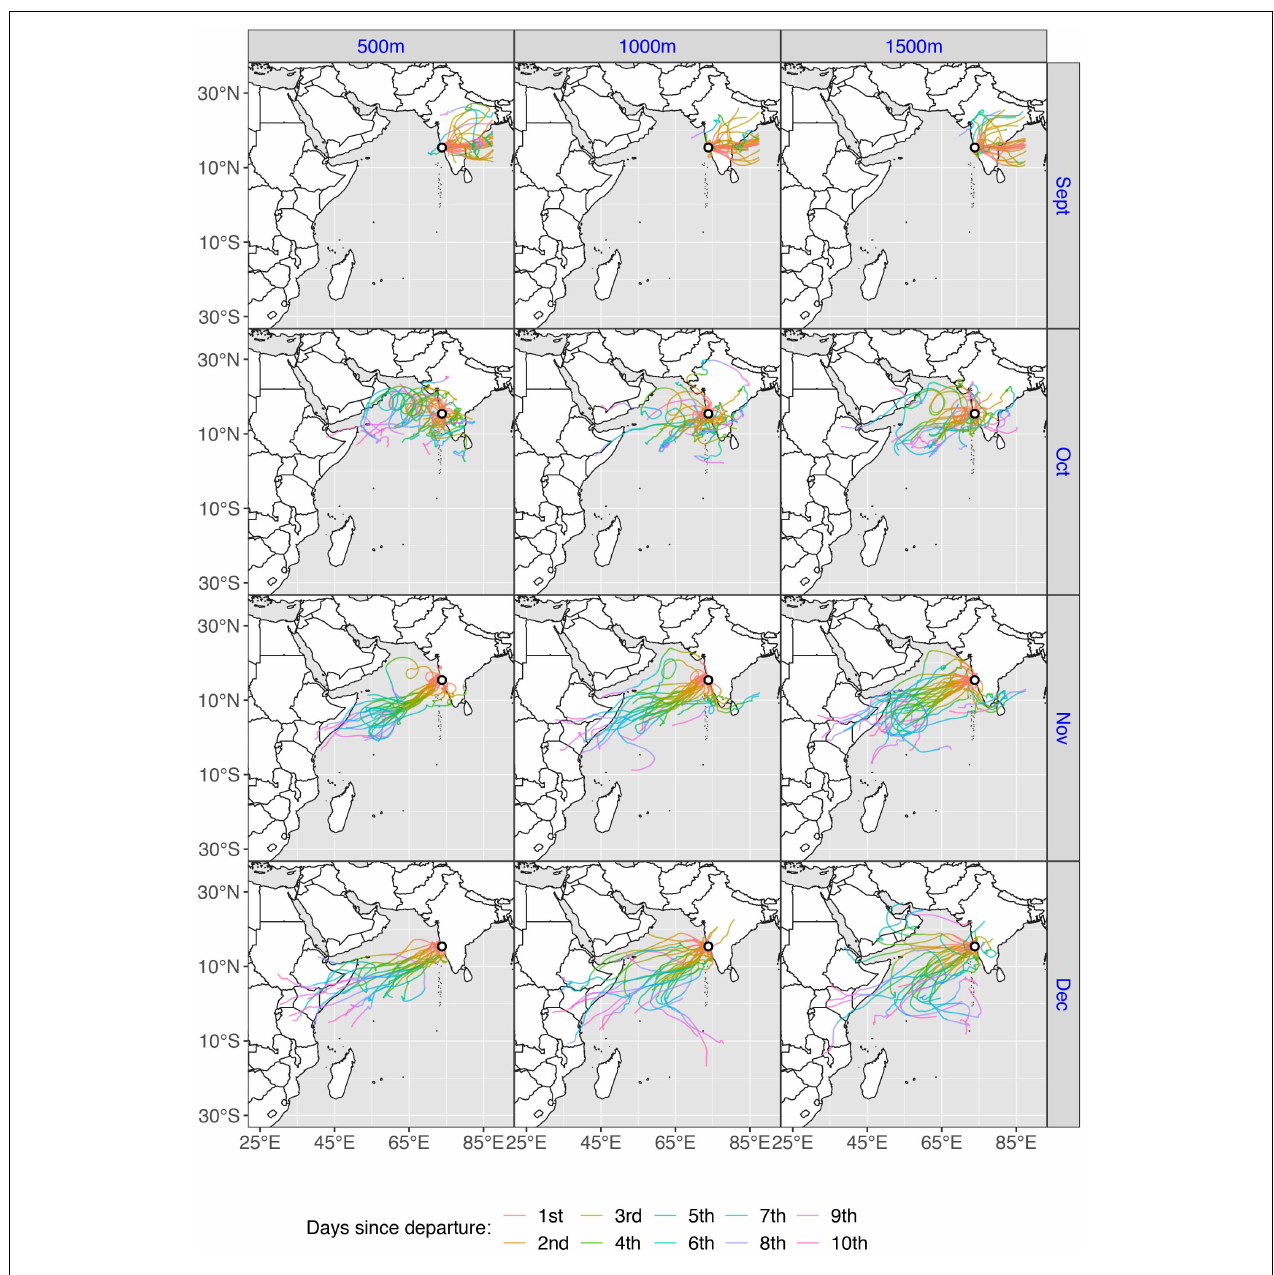
FIGURE 5 | Autumn wind trajectories ( N = 366), during September–December, for three starting heights (500, 1,000, and 1,500 m) from the departure site Vasco da Gama, Goa, western India. Colors denote the number of days since departure (1–10). As the model adheres to a limited geographical scope, trajectories that exceeded the boundary (approximately 87 ◦ E longitude) will stop, thus trajectories traveling eastward across the Bengal Sea are cut